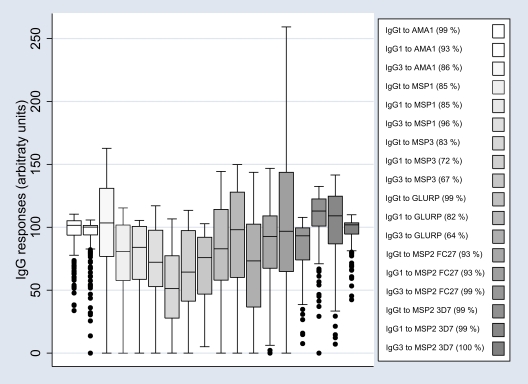
IgG antibody levels in all participants.Total and cytophilic IgG subclass (IgG1 & IgG3) levels of 273 individuals (HBB AS carriers excluded) with specificity for the panel of asexual blood stage antigens of P. falciparum. Box-whisker plots represent medians with 25th and 75th percentiles (boxes), and with 10th and 90th percentiles (whiskers), outliers as discrete dots. The prevalence of positive responders to each recombinant proteins is noticed between brackets. A positive responder was defined as an individual who had a level of specific IgG over the positivity thresholds. These positivity thresholds were determined, for total IgG, IgG1 and IgG3 to each recombinant proteins, from the mean reactivities+2 SD of 30 plasma samples from Dutch non-immune volunteers.